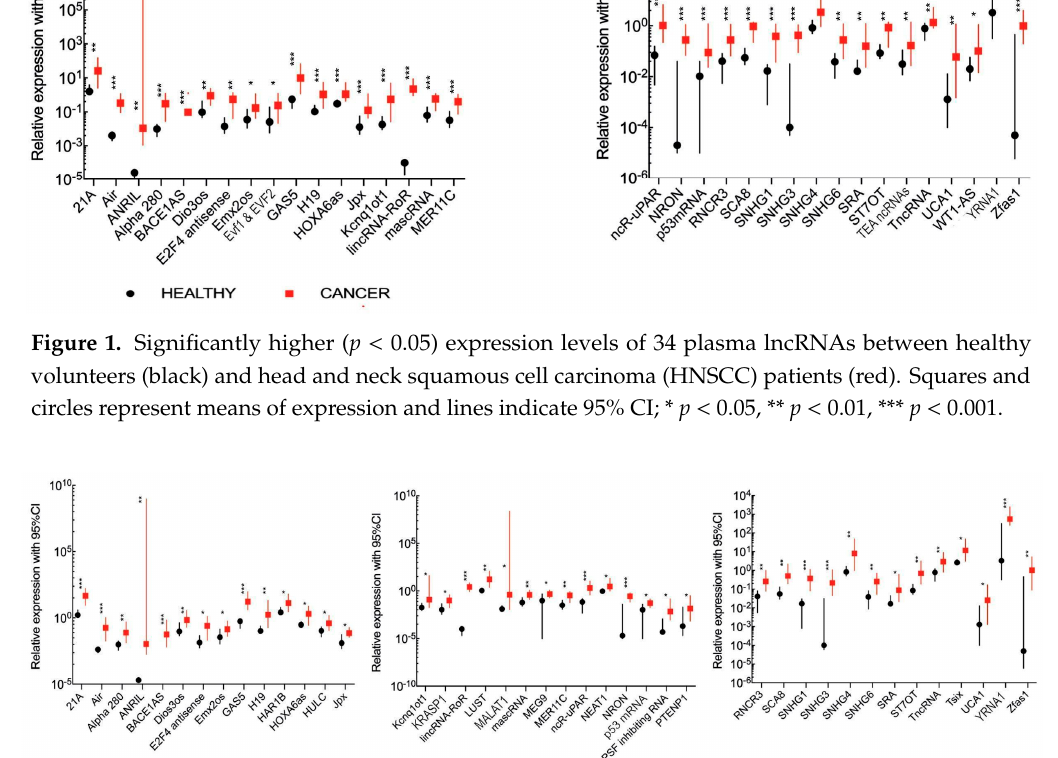
Figure 1. Significantly higher ( p < 0.05) expression levels of 34 plasma lncRNAs between healthy volunteers (black) and head and neck squamous cell carcinoma (HNSCC) patients (red). Squares and circles represent means of expression and lines indicate 95% CI; * p < 0.05, ** p < 0.01, *** p < 0.001.